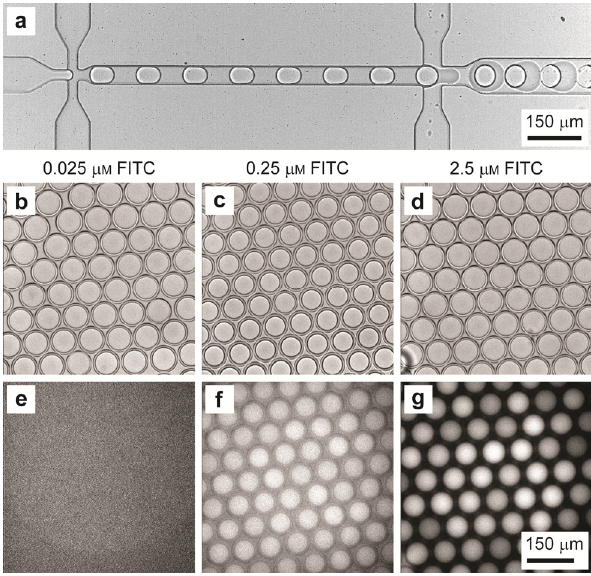
Figure 2. Production and analysis of w/o/w double emulsion samples with varying fluorescein isothiocyanate (FITC) contents. ( a ) Formation of w/o/w droplets in a microfluidic device with double flow-focusing geometry; ( b – d ) Brightfield micrographs of w/o/w emulsion samples inside storage devices. The inner droplets contain 0.025 μ M, 0.25 μ M or 2.5 μ M FITC in PBS, respectively; and ( e – g ) Corresponding fluorescence micrographs. Fluorescence signals above background are present for 0.25 μ M FITC droplets and, even stronger, for 2.5 μ M FITC